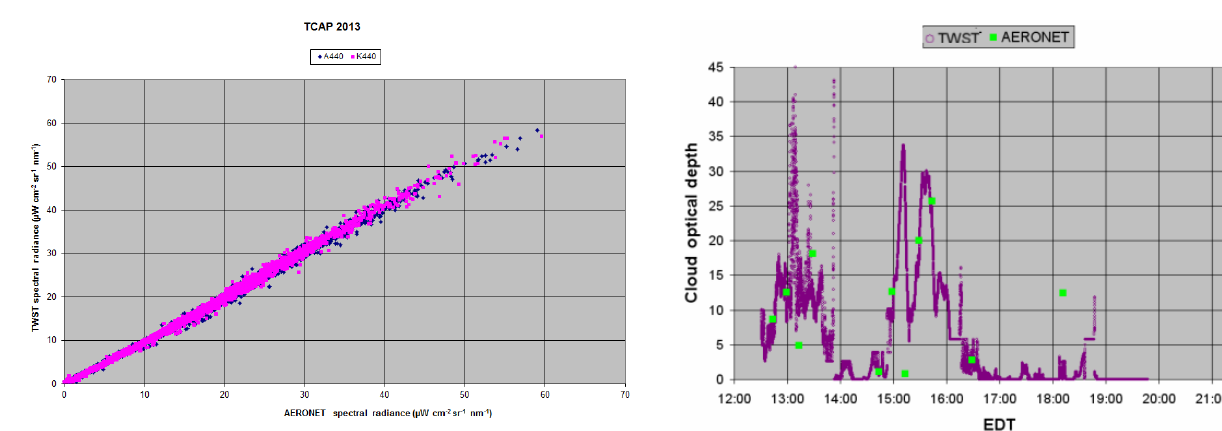
Figure 15. COD time series comparison between AERONET and TWST for 14 June 2013 at the ARM TCAP field